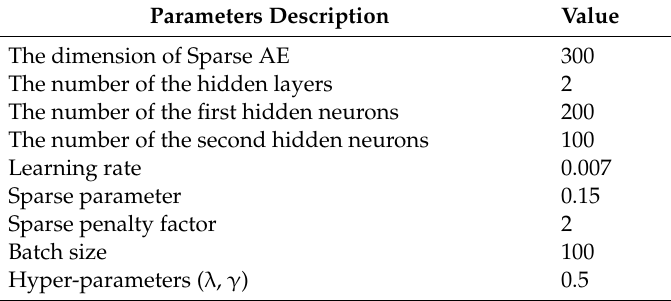
Table 4. Key parameters of the proposed